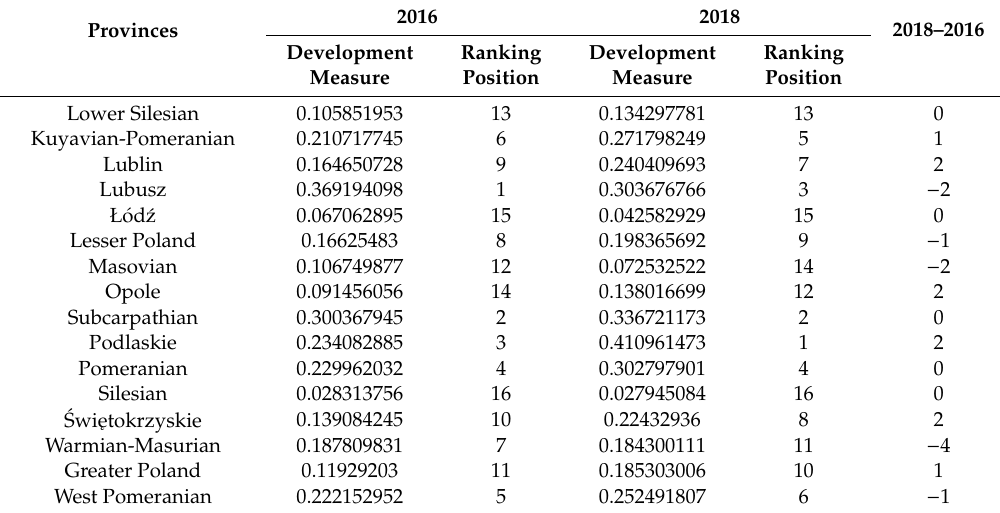
Table 3. Ranking of provinces based on the integrated measure of sustainable development in the area of environmental order in the years 2016 and 2018.